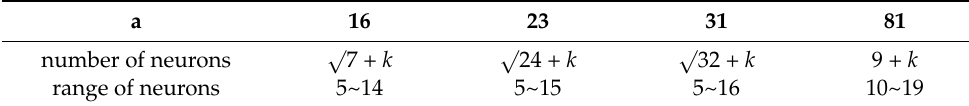
Table 4. BP neural network calculation of the number of neurons in the hidden layer.